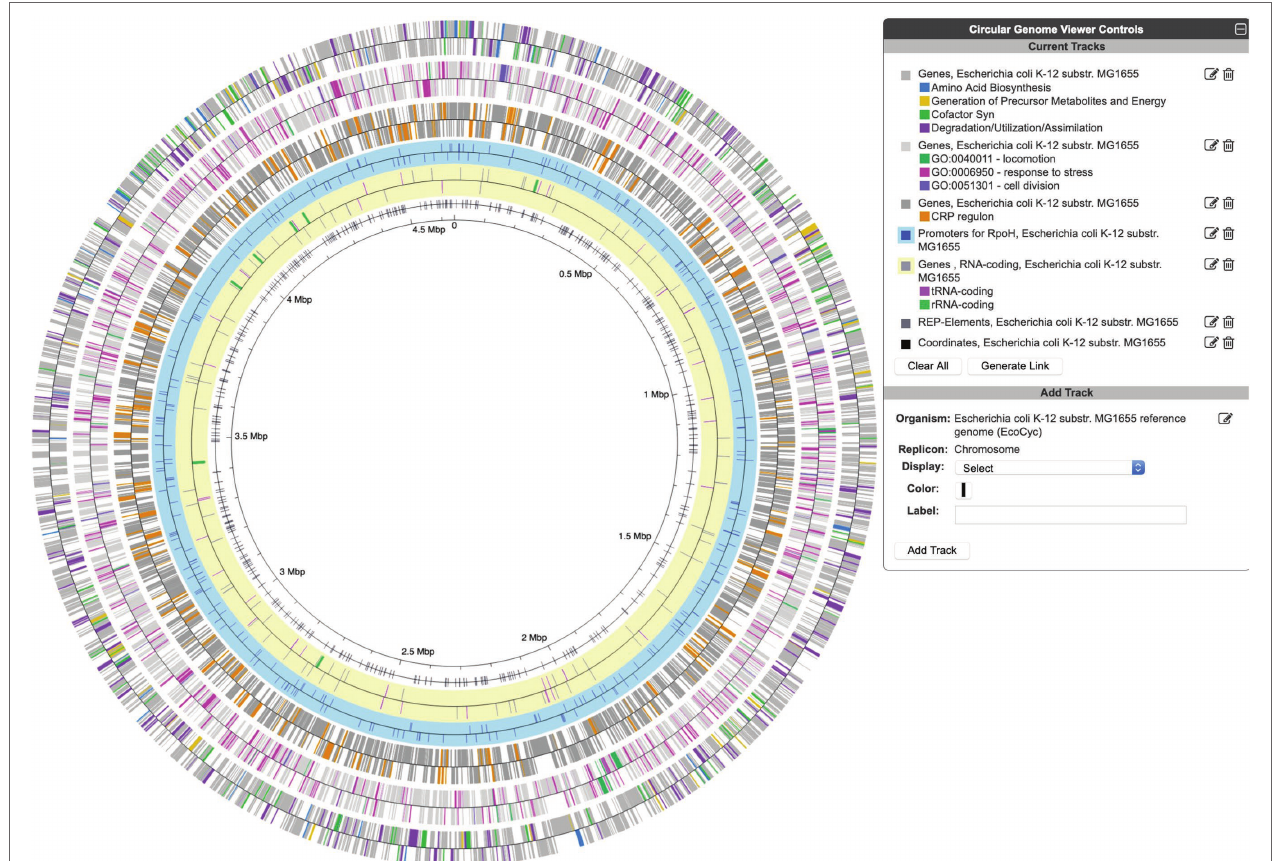
FIGURE 4 | An example Circular Genome Viewer display, with tracks that showcase a variety of feature types, filtering and highlighting options, listed in order from the outermost circle